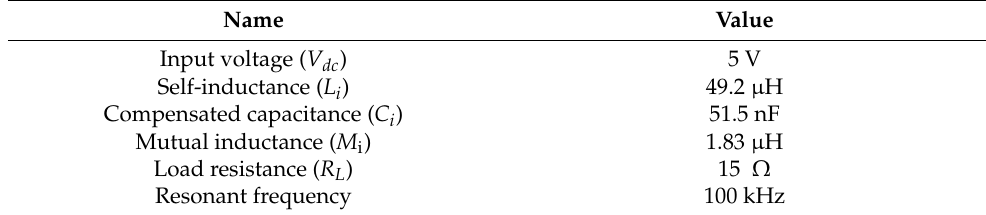
Table 1. Simulation parameters of the proposed domino WPT